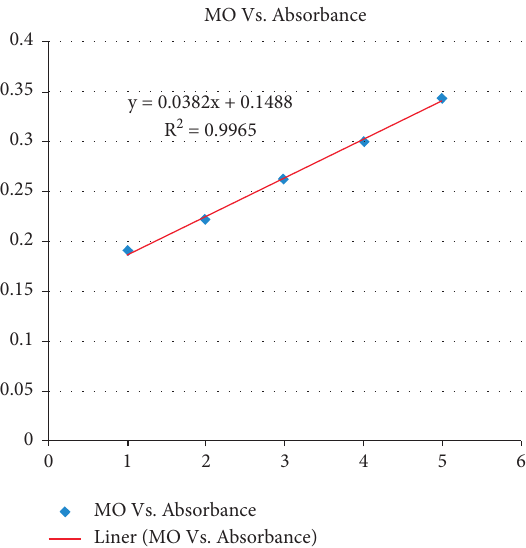
Figure 6: Methyl orange dye concentrations versus